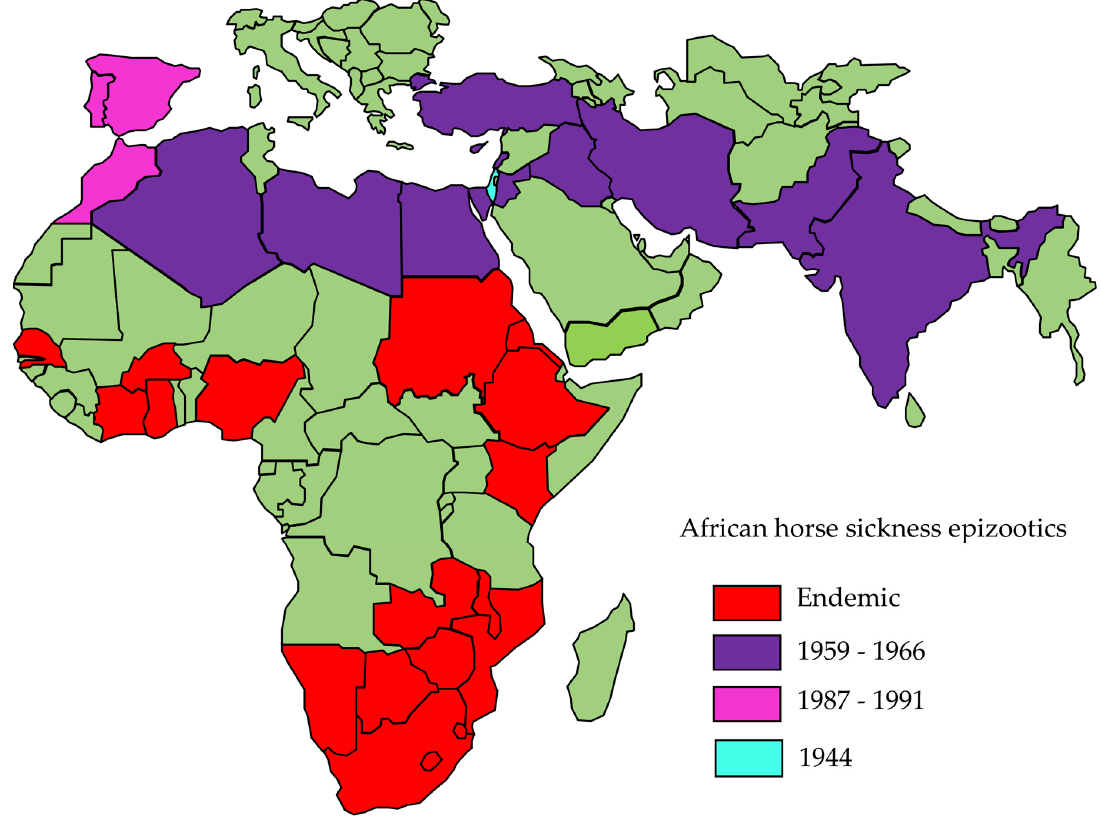
Figure 1. A map of African horse sickness outbreaks that have occurred worldwide during the last century